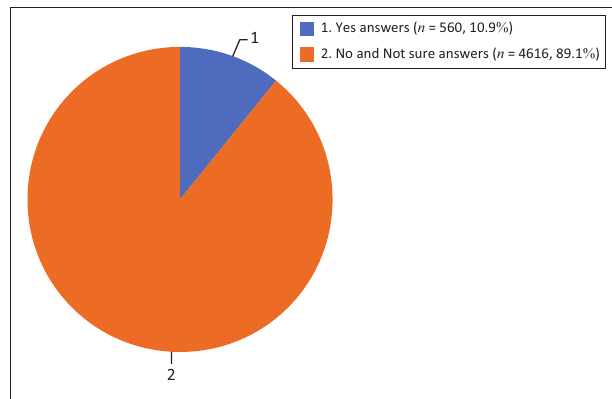
FIGURE 1: Overall awareness on health risks associated with smokeless tobacco products